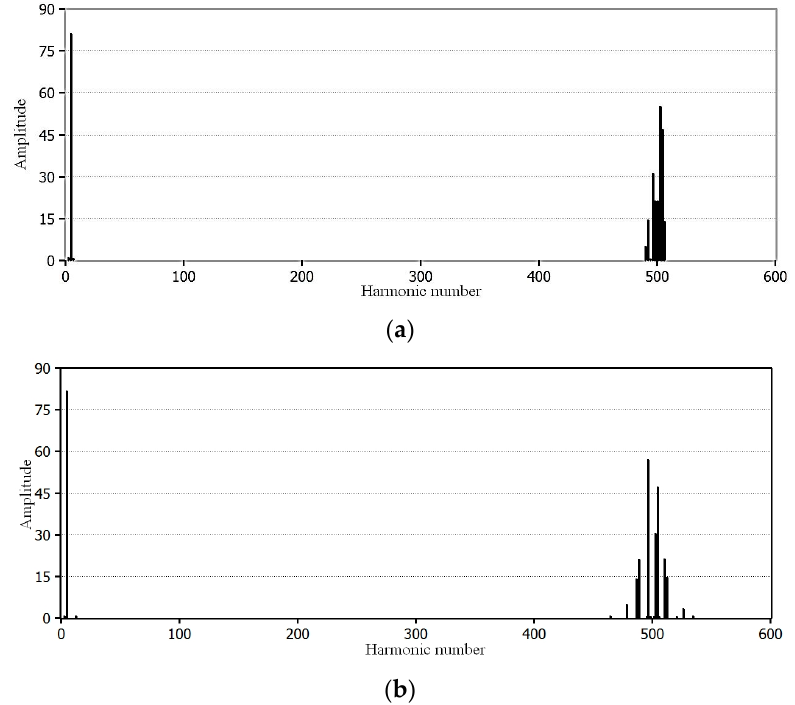
Figure 7. Fourier analysis of input current of phase a for ( a ) CCW method and ( b ) CW method.